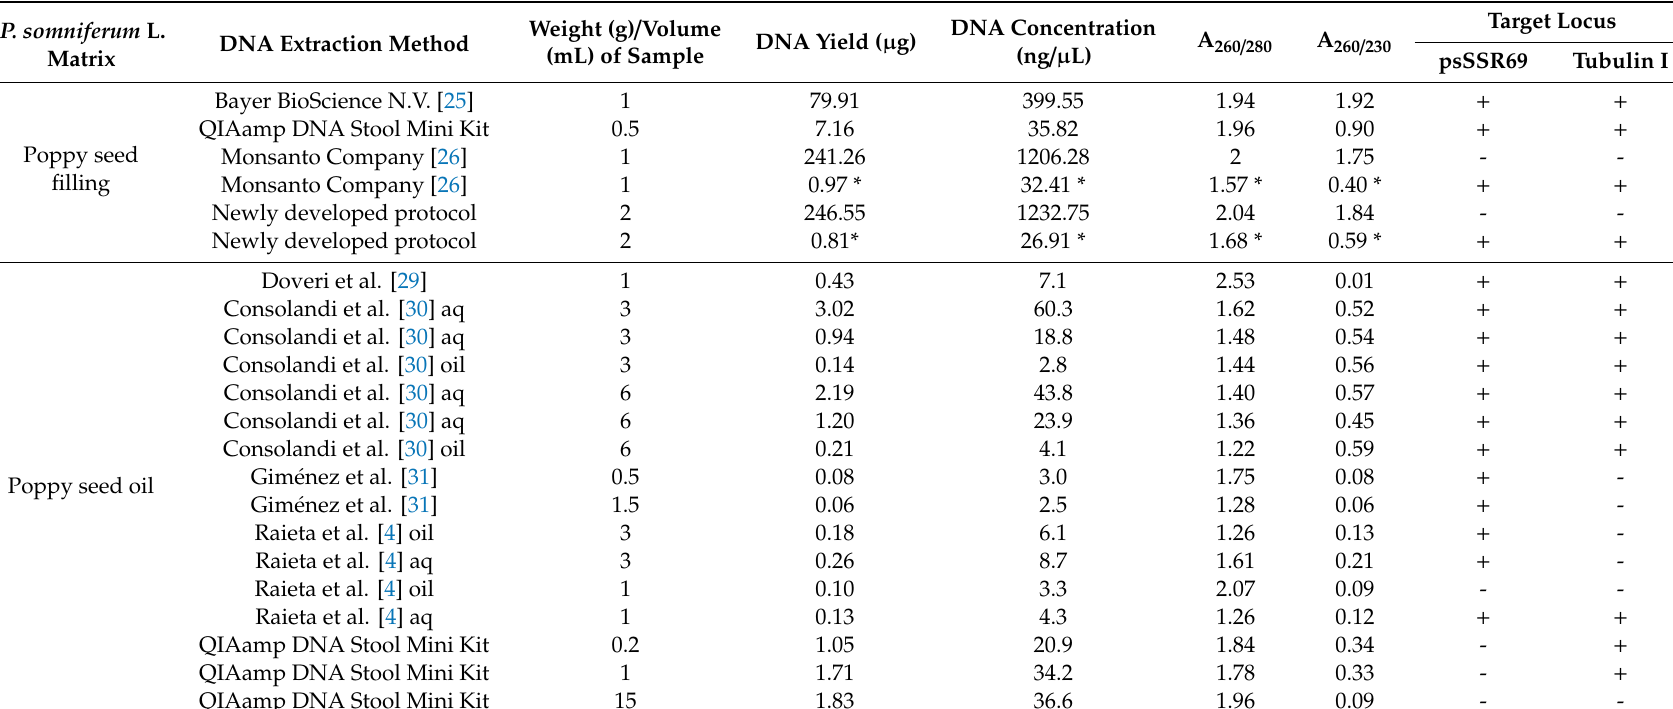
Table 3. Parameters of DNA extracted from poppy seed filling and poppy seed oil using di ff erent extraction procedures and commercial kits. P. somniferum